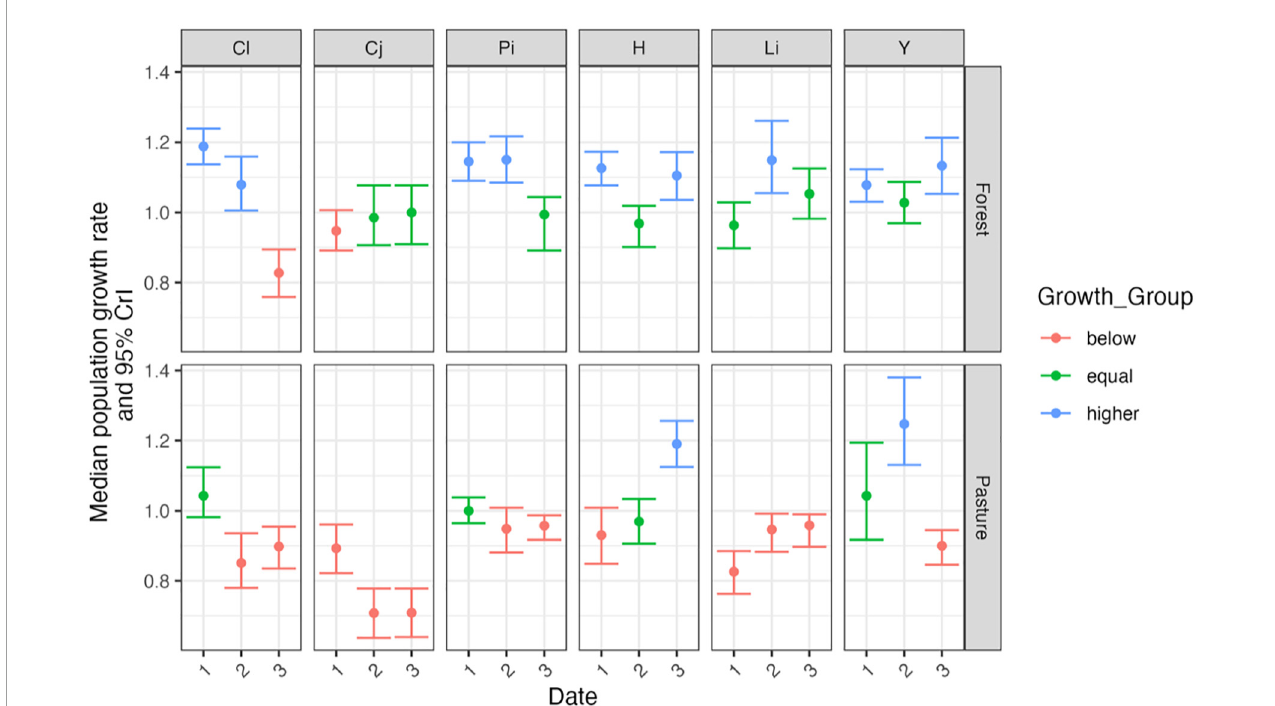
FIGURE3 Median posterior asymptotic population growth rate and 95% credible intervals estimated for Rodriguezia granadensis population at two subsites, Forest and Pasture in six Sites (Cauca sites: Cl, Calibío; Cj, Cajibío; Pi, Piendamó. Valle sites: H, Hondonada; Li, Lilas; Y, Yotoco), over three time periods; Time 1, Mar.–Oct. 2017; Time 2, Mar. 2017–Oct. 2018; Time 3, Mar.–Oct. 2018. Red are populations/time periods where lambda was significantly smaller than 1, green for lambda equal to one (not significantly different from stability), and blue for lambda significantly larger than